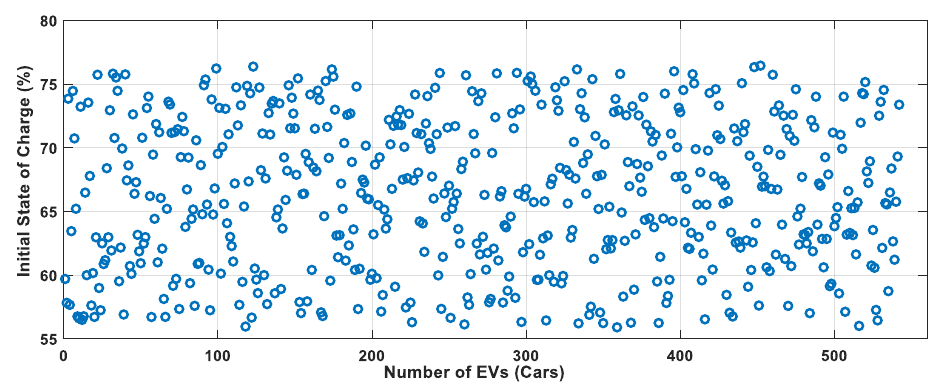
Figure 5. Initial state of charge of 100% penetration (542 cars).